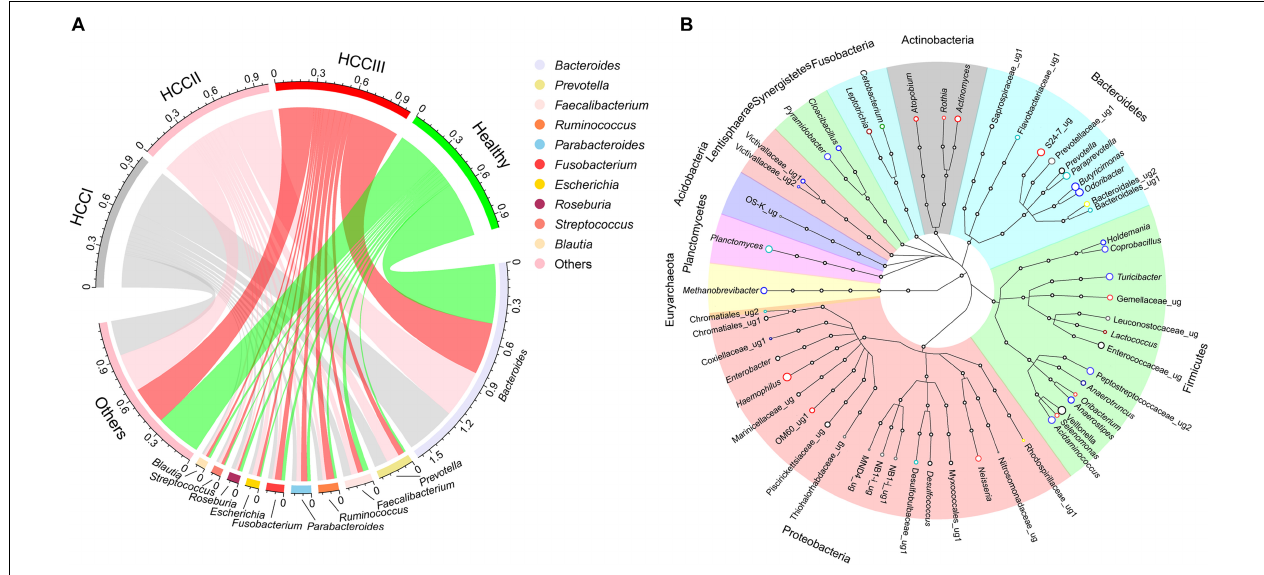
FIGURE 2 | Circular layout (A) and Cladogram layout (B) depict the top 10 genera found in the fecal microbiota, as well as significantly different genera found in the gut microbiota among patients with different primary HCC stages and the healthy controls. Primary HCC samples were staged as previously described (Zhou et al., 2018). Circle colors in the layout (B) show changes in genera within the fecal microbiota of patients expressing different stages of primary HCC, compared with healthy controls. The genera that were enhanced include yellow (stage I), gray (stage II), light red (stage III), pink (stages I and II), red (stages I and III), dark red (stages II and III), and black (stages I, II and III). The genera that were reduced by color bright green (stage I), green (stage II), blue (stage III), pale green (stages I and II), light blue (stages I and III), dark blue (stage II and III), and dark green (stages I, II and III),